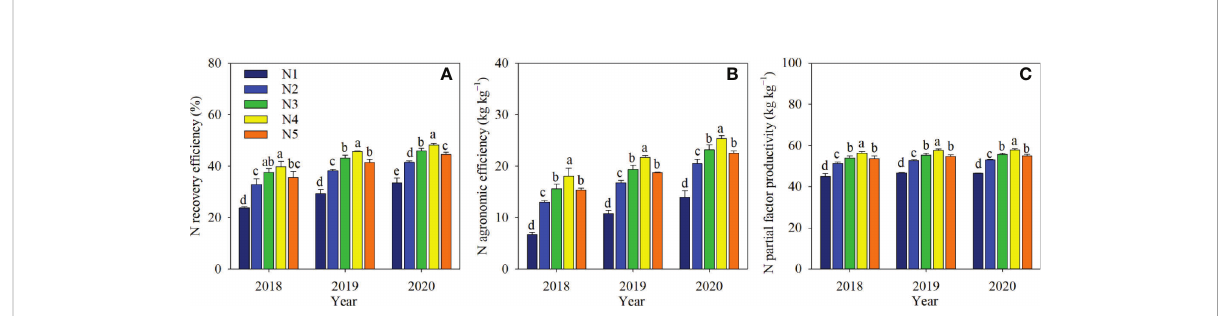
FIGURE 5 N recovery ef fi ciency (A) , N agronomic ef fi ciency (B) , and N partial factor productivity (C) in different N application treatments in 2018, 2019, and 2020. Different letters above columns in each year indicate signi fi cant differences in N ef fi ciency (P< 0.05). Error bars represent the standard